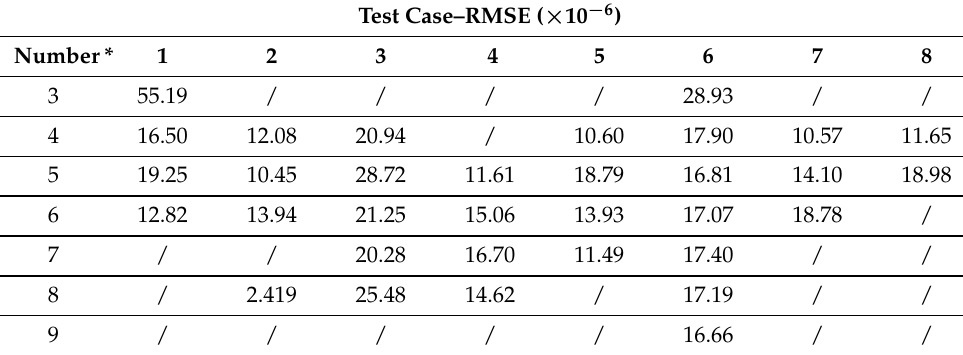
Table 4. RMSE [mol/m 2 ] in comparison to the number of considered IoT sensors. The results were obtained from the neural networks, applied on the testing dataset.